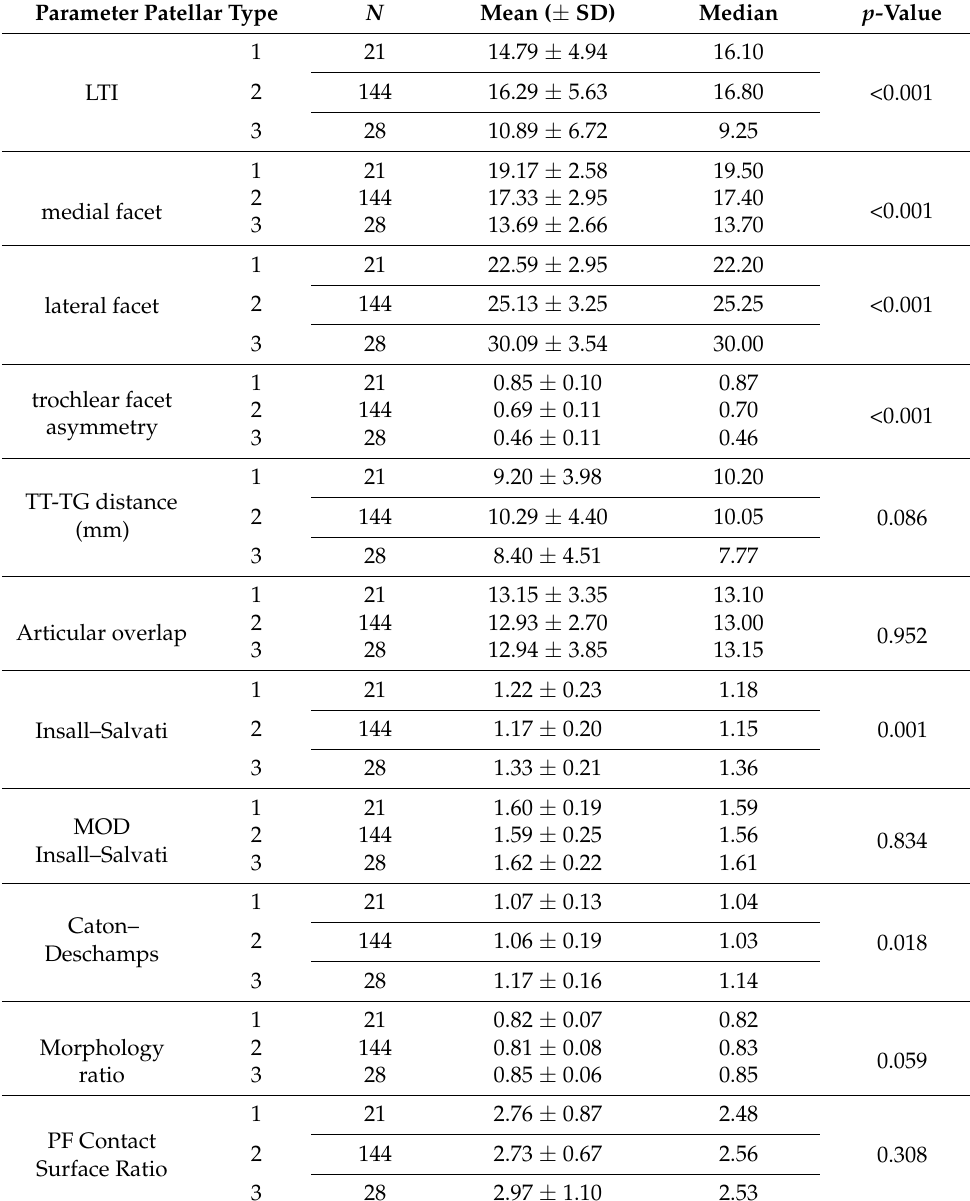
Table 4. Morphometric parameters by patellar type (Wiberg